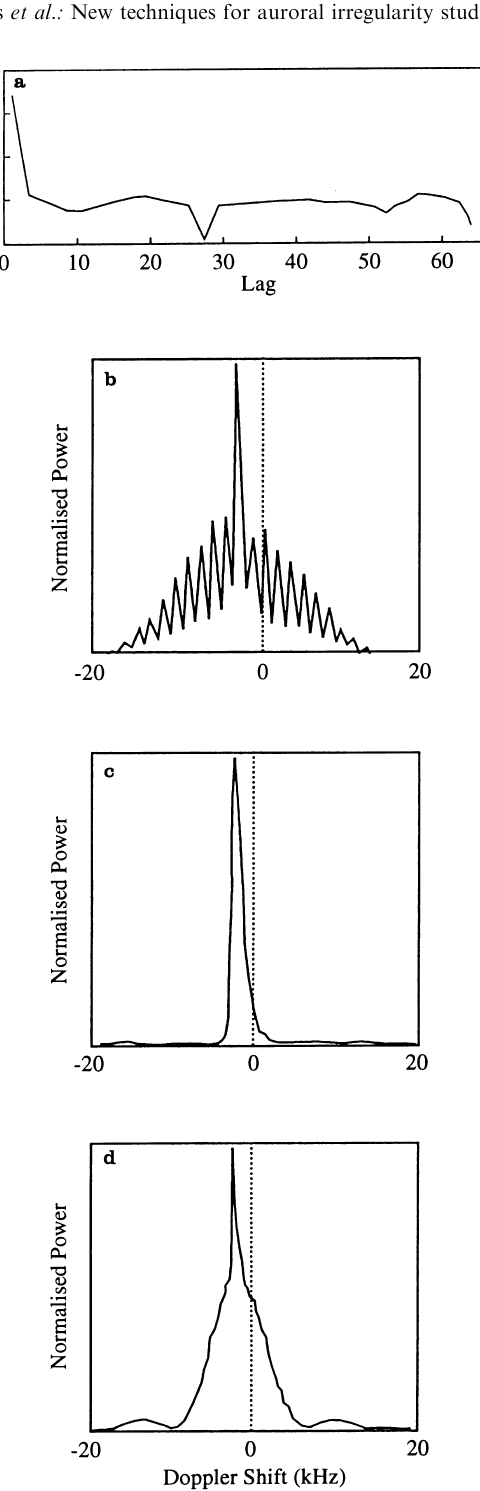
Fig. 4. a depicts an ACF observed by the COSC experiment when a 40- (cid:108) s Barker code was being transmitted. b , c and d , exhibit the measured spectrum at Kiruna for 40, 70 and 100 (cid:108) s, respectively